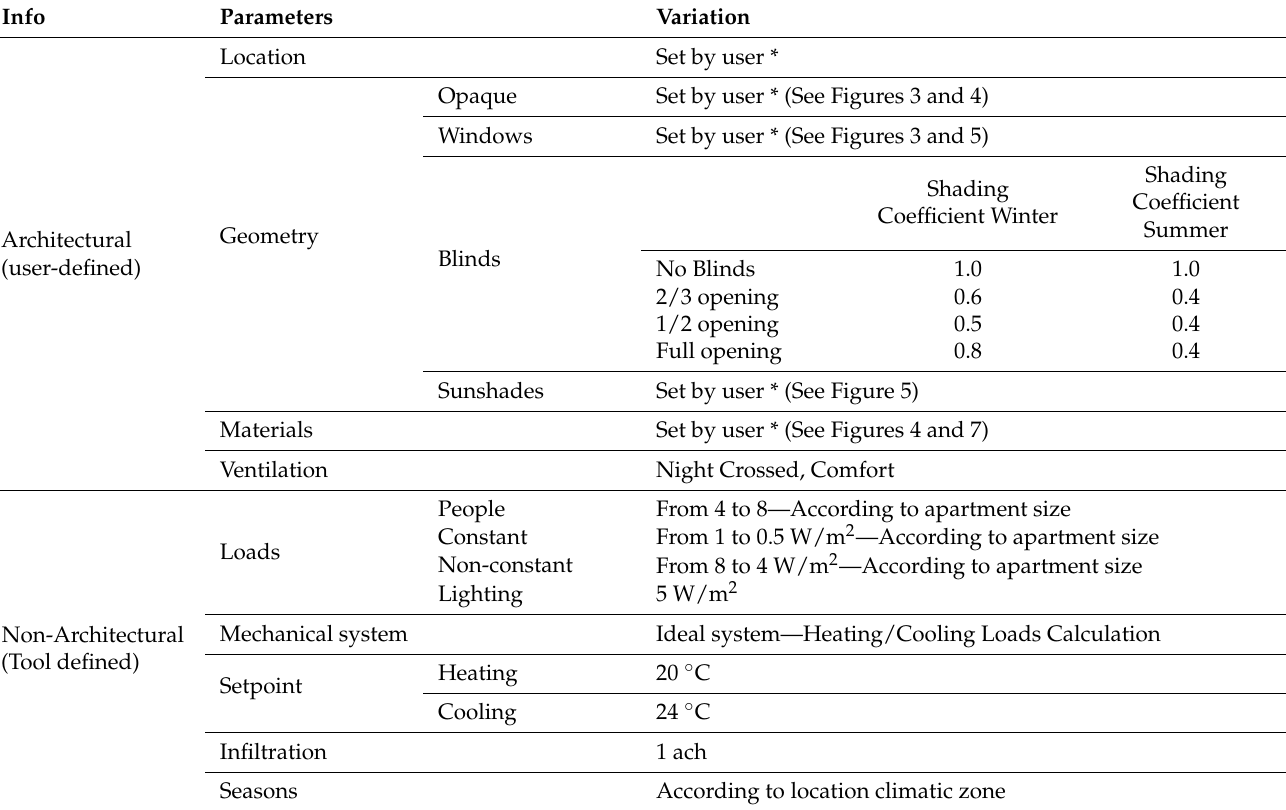
Table 2. Architectural and non-architectural parameters for residential building type.